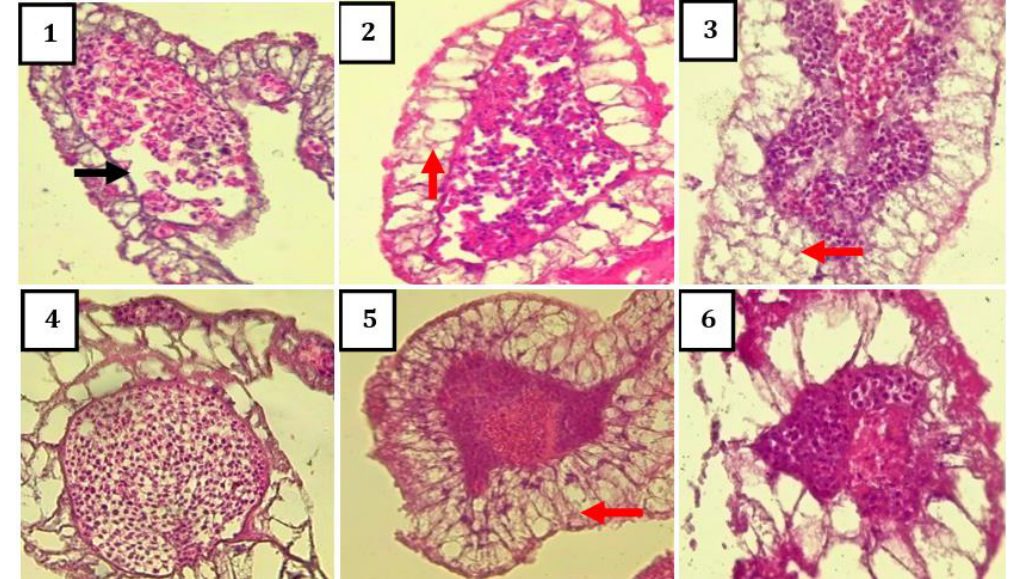
Figure 4. Histological images of CAM and blood vessels with HE. 1: bFGF, 2: Thylophorine, 3: Extract 13.00 mg/mL, 4: Extract 9.75 mg/mL, 5: Extract 6.50 mg/mL, 6: Extract 3.25 mg/mL; black arrows: main blood vessel, red arrows: new blood vessel, magnification: